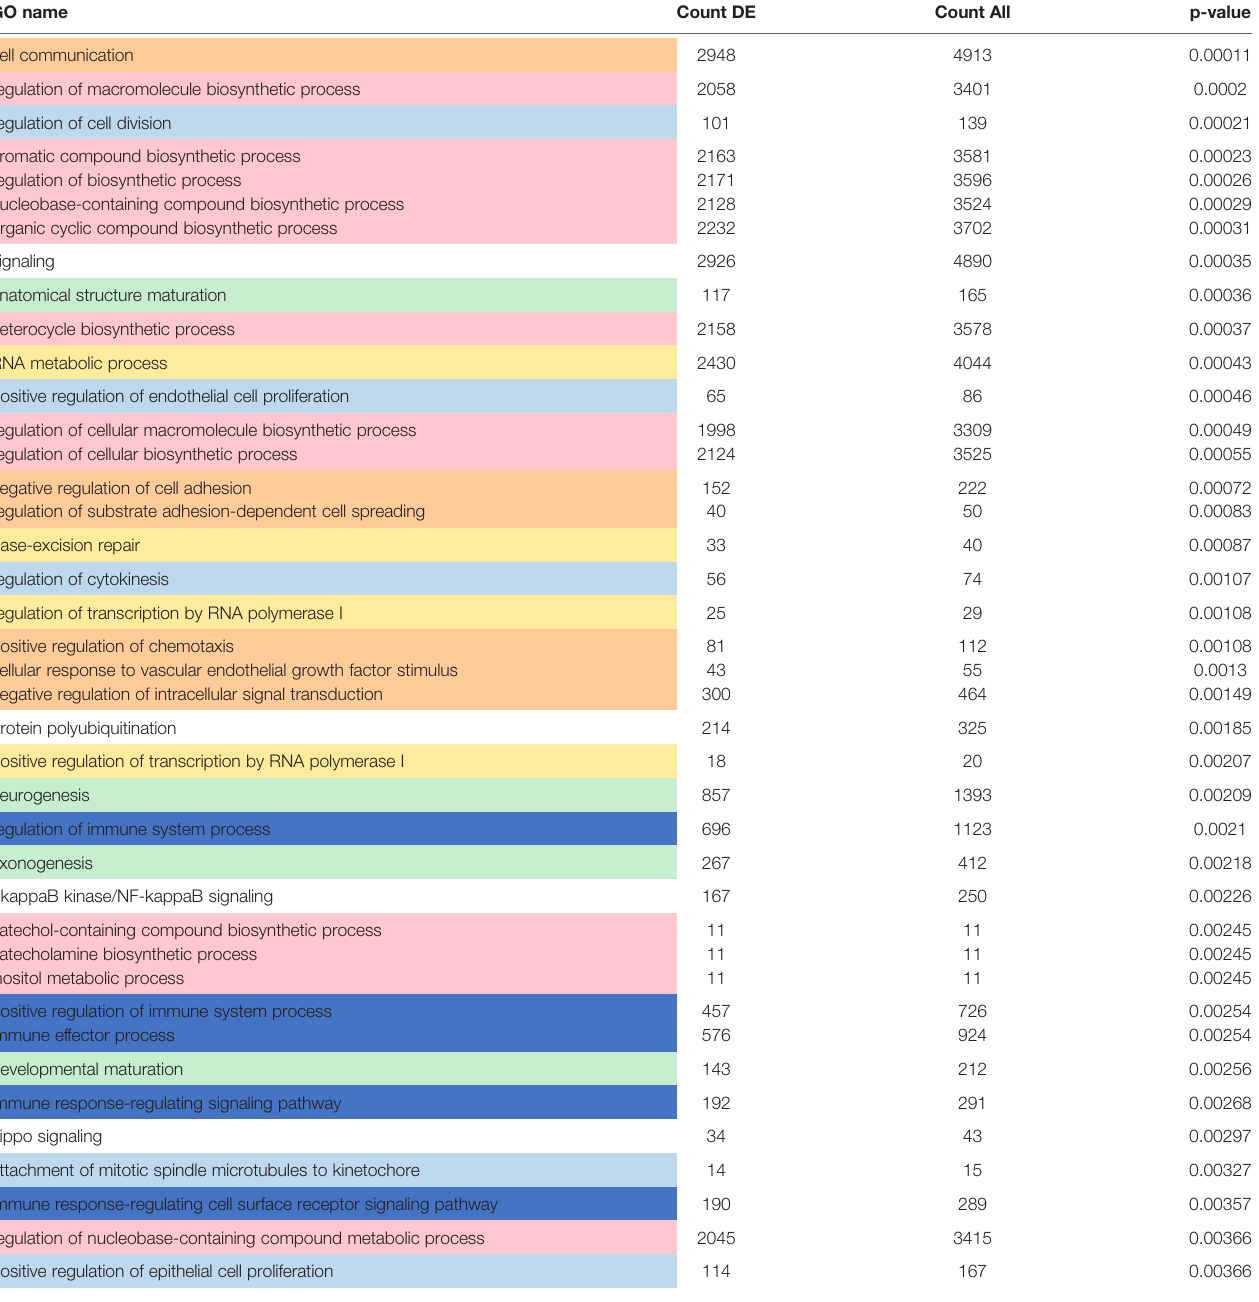
Table is sorted based on p-value. Group color: Biological processes related to cell communication (orange), biosynthetic and metabolic process (red), cell proliferation (light blue), development(green),DNAandRNAregulation(yellow)andimmuneresponse(darkblue).TheCountDEcolumnshowsthenumberofDEgenesineachbiologicalprocess,andtheCount All column shows how many genes are in this GO term. The full output table is shown in Supplementary Table 7 . DE, differentially expressed; GO, gene